Question: Briefly state, in one sentence, what is plotted here.
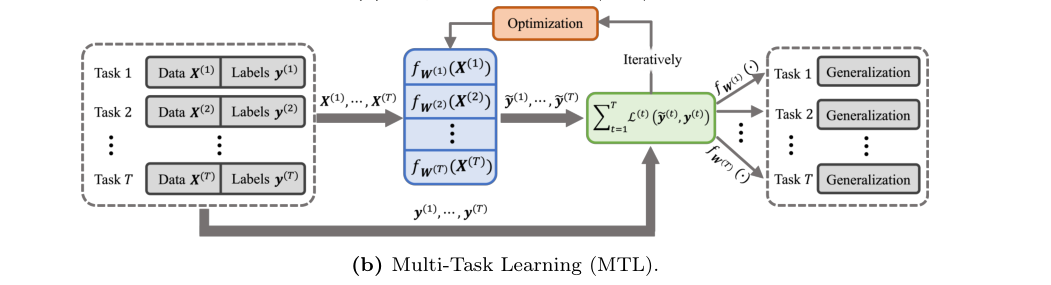
Answer: The comparison of general framework between STL and MTL. (a) In STL, the learning function f is trained on a single dataset (X, Y ), where X represents the input data and y represents the corresponding labels. The function f is parametrized by W , and is trained to minimize a predefined loss function L( ˜Y , Y ), where ˜Y is the prediction value. Once f is trained, it can be used to generalize to unseen data. (b) In MTL, the learning pipeline is similar to STL, but instead of training on a single dataset, multiple datasets are combined for different tasks. The multiple tasks are learned jointly by optimizing multiple loss functions L(1)( ˜Y (1), Y (1)), ..., L(T )( ˜Y (T ), Y (T )) simultaneously. It should be noted that although multiple tasks are learned jointly, the generalization of each task can still be performed independently.